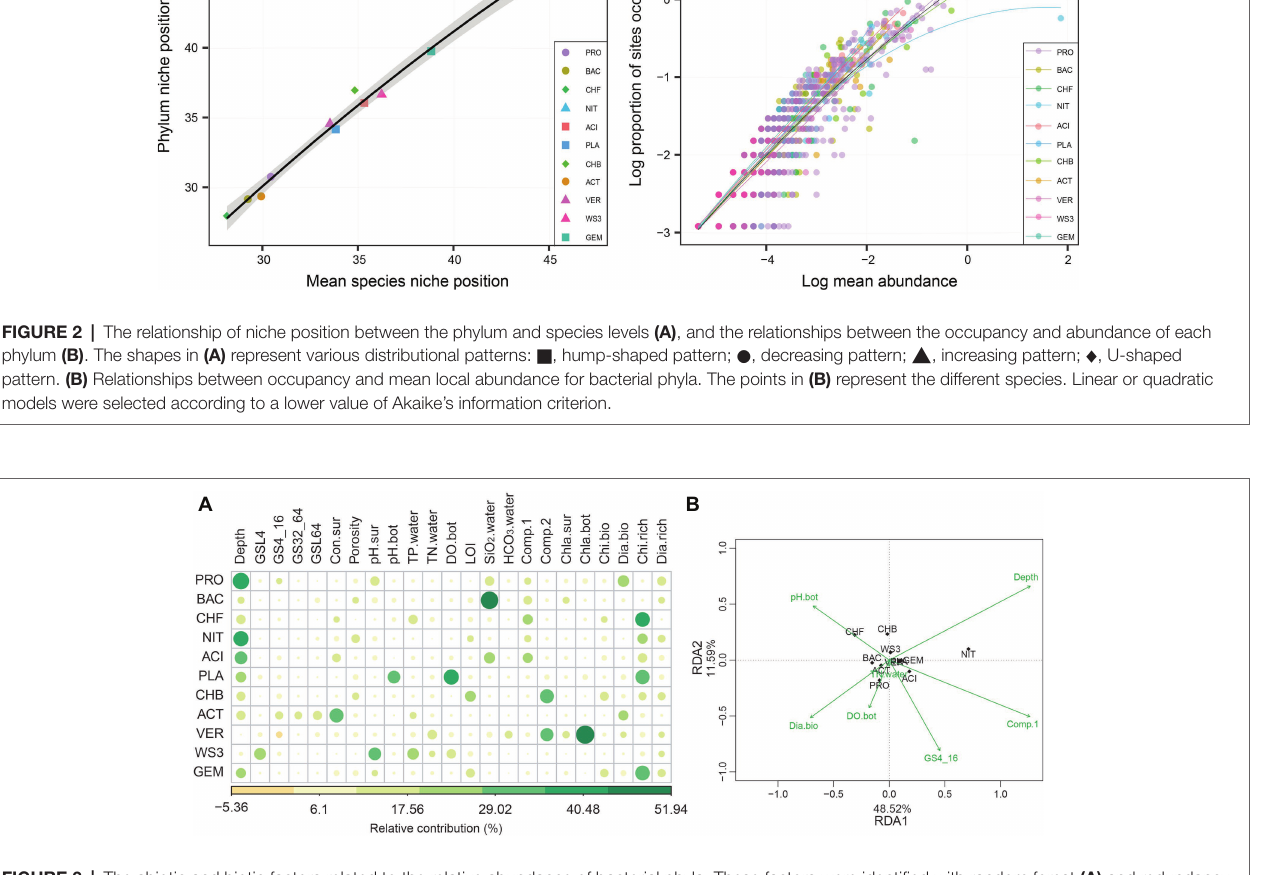
FIGURE 3 | The abiotic and biotic factors related to the relative abundance of bacterial phyla. These factors were identified with random forest (A) and redundancy analysis (RDA, B ). For abiotic factors, we considered water depth (depth), total phosphorus (TP.water), total nitrogen (TN.water), conductivity (Con.sur) and concentrations of and > 64 μm (GSL64). Biotic factors included the biomass (Dia.bio and Chi.bio) and richness (Dia.rich and Chi,rich) of diatoms and chironomids, and chlorophyll a (Chla.bot and Chla.sur). For RDA, the abiotic variables were automatically selected based on Monte Carlo permutation tests (999